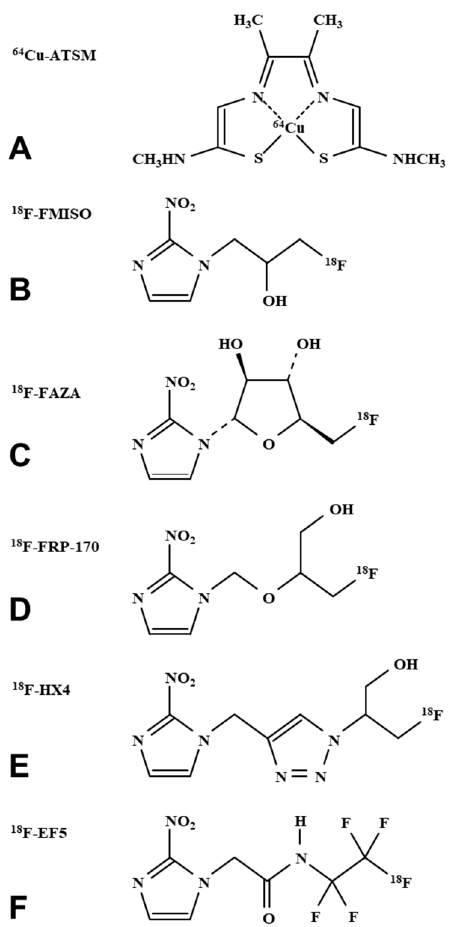
Figure 1. Chemical structures of PET probes seeking tissue hypoxia. ( A ) 64 Cu-ATSM has a chelated radioactive 64 Cu 2+ on the ATSM, which is a1 copper chelator. ( B ) 18 F-FMISO, ( C ) 18 F-FAZA, ( D ) 18 F- FRP-170, ( E ) 18 F-HX4, and ( F ) 18 F-EF5 were all labeled by a radioactive 18 F and have a nitroimidazole ring on the molecule.